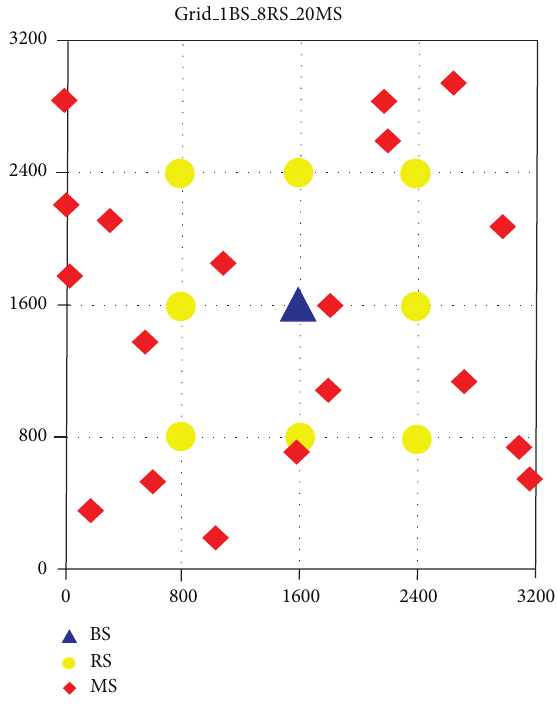
Figure 5: Grid topology